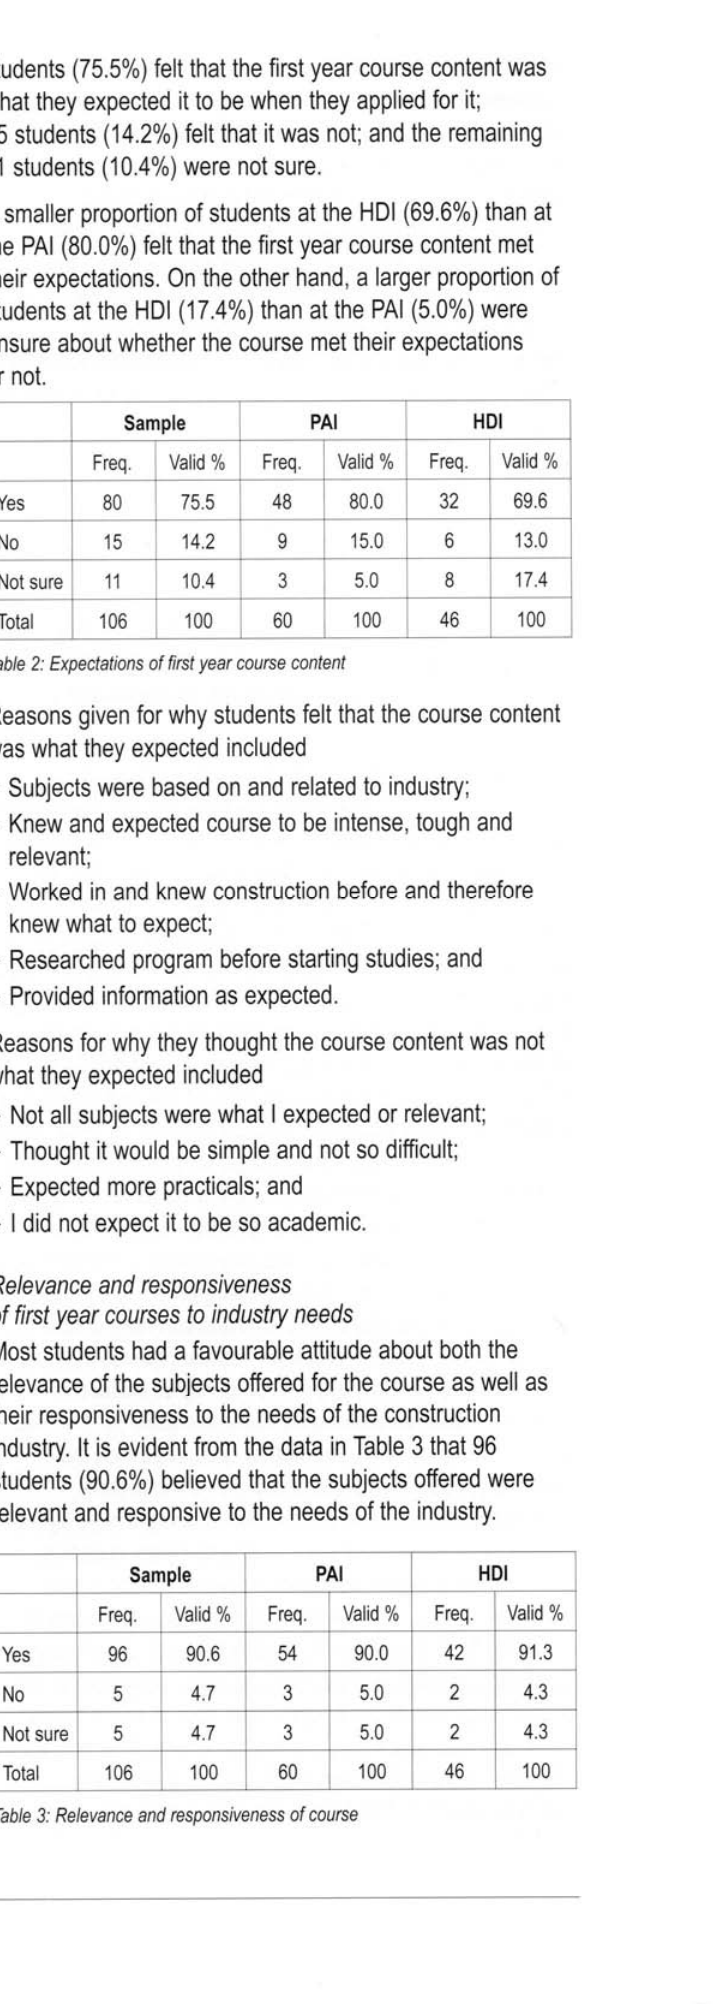
Table 3: Relevance and responsiveness of